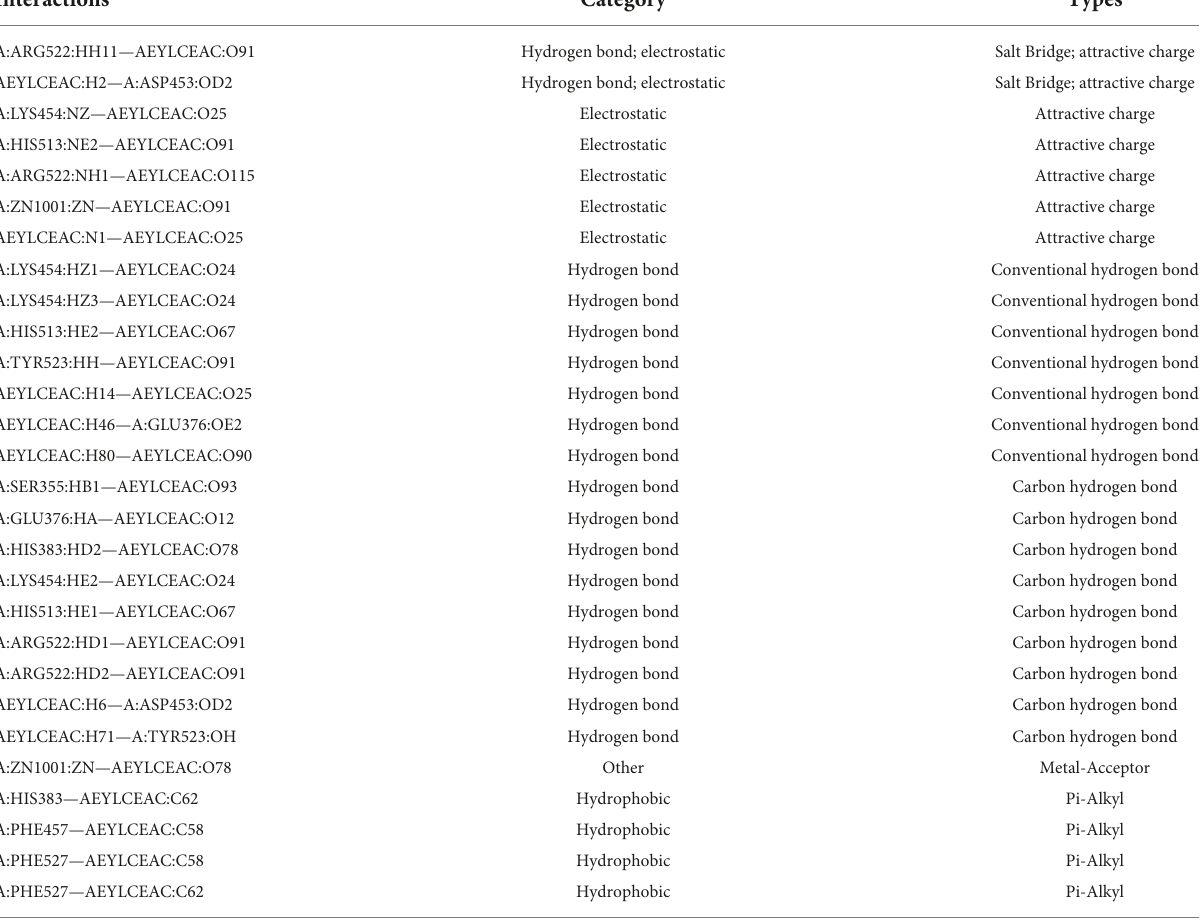
TABLE 3 The types of hydrogen bond, electrostatic and hydrophobic interactions of oyster peptide (AEYLCEAC) against ACE.